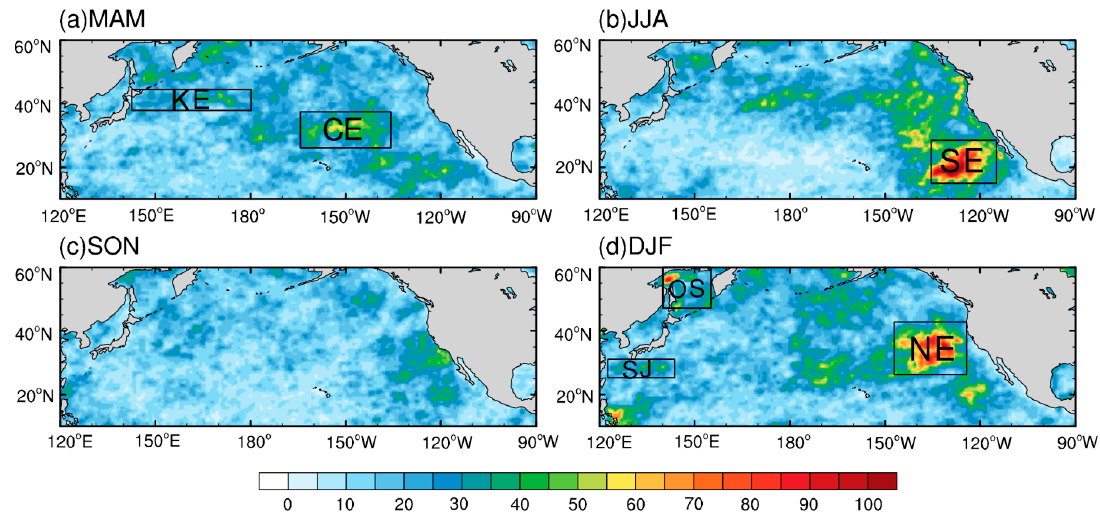
Figure 6. Interannual LCF variance (shading; units: % 2 ) in ( a ) spring, ( b ) summer, ( c ) autumn, and ( d ) winter. Thick solid rectangles designate different regions discussed in Section 4.